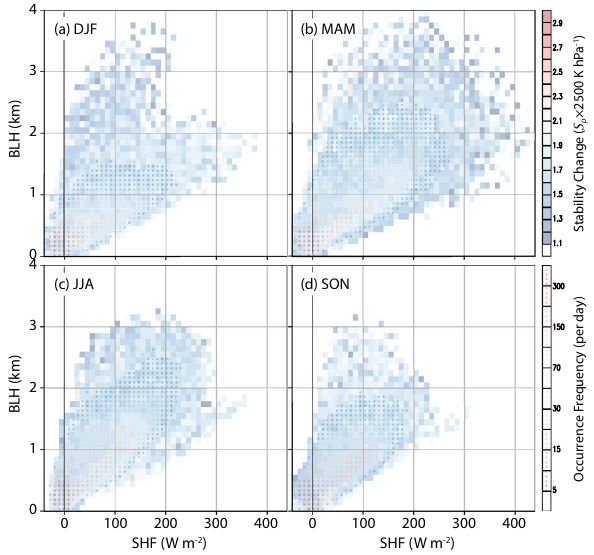
Fig. 7 Seasonal scatter plot of stability (shade; S p × 25 K hPa −1 ) over land in SHF-BLH space for the first CSEOF mode (diurnal/seasonal cycle): a DJF, b MAM, c JJA, and d SON. The colored dots represent